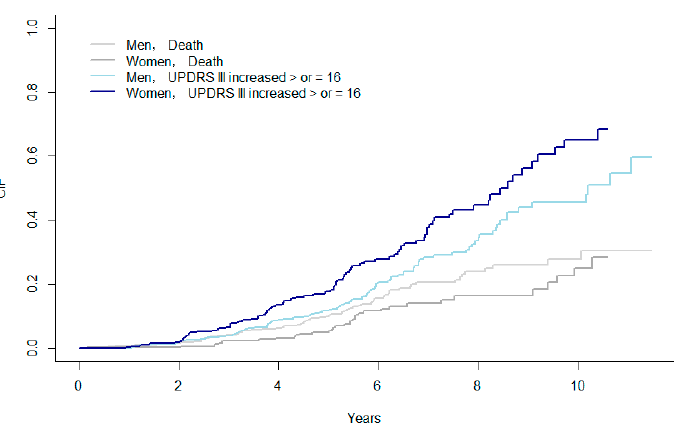
Figure 1. CIF between female and male PD patients. Note: CIF, cumulative incidence functions; UPDRS, Unified Parkinson’s Disease Rating Scale.